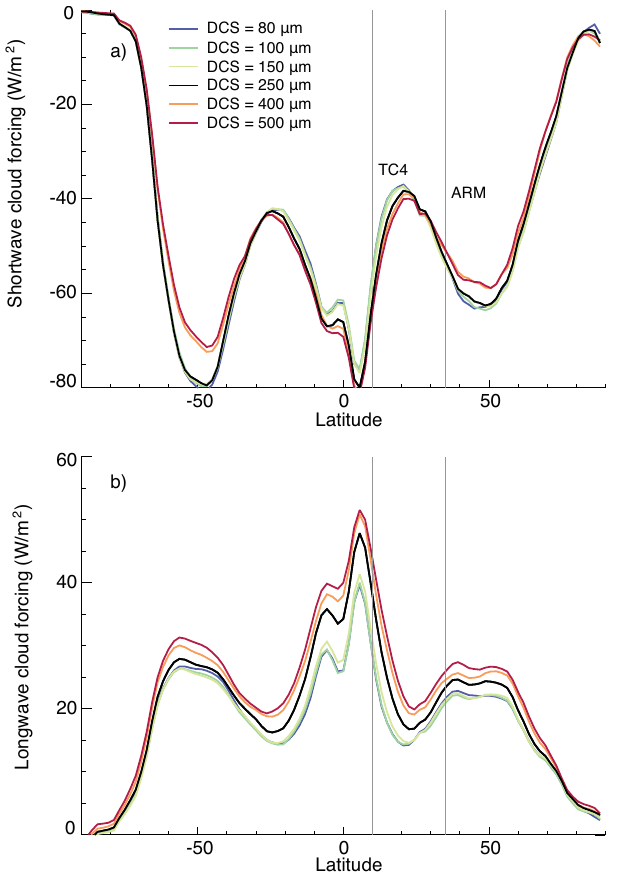
Figure 13. Zonal averaged shortwave and longwave radiative cloud forcing for the six runs, varying D cs .